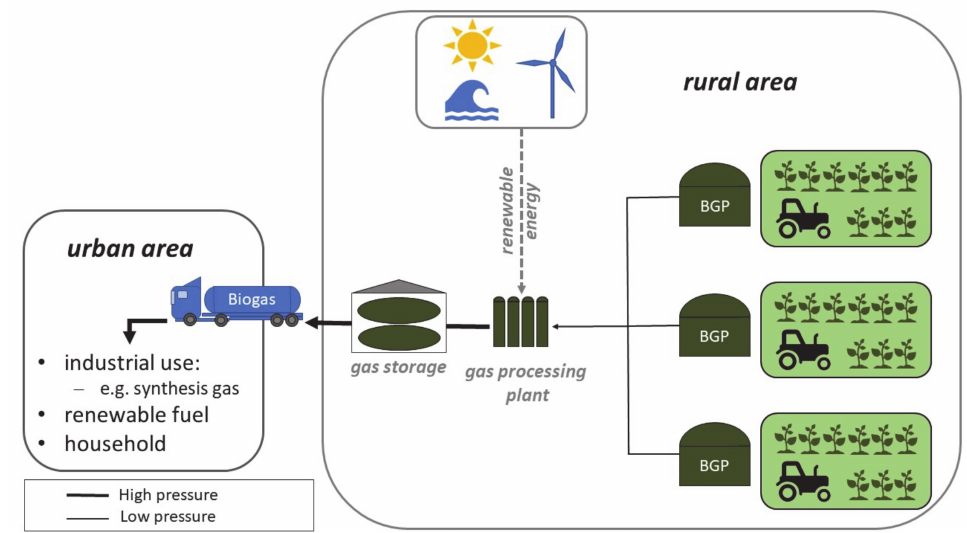
Figure 6. Farm 2 CBG: A possible concept for biogas distribution via pipelines or as compressed biogas (CBG) from rural biogas plants (BGP) to urban areas in Brazil.